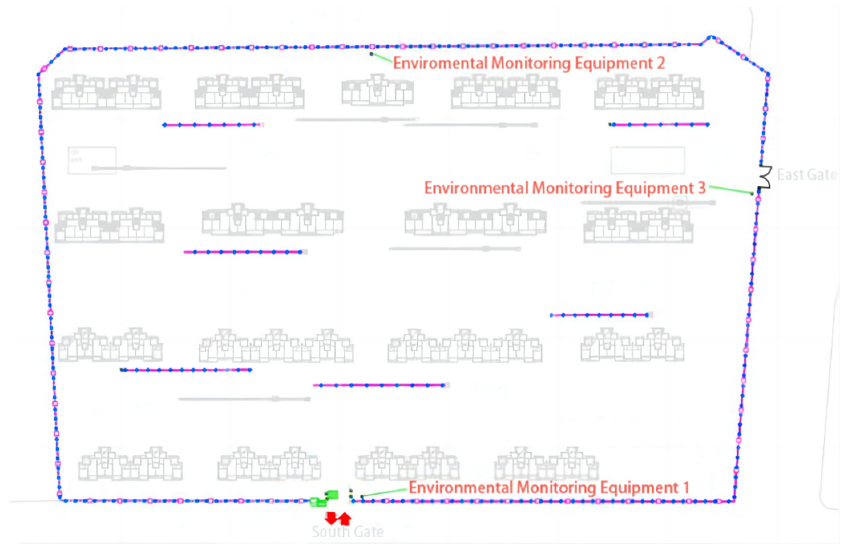
Figure 7. Position of the environmental monitoring equipment. Table 6. Raw data exported by the platform.